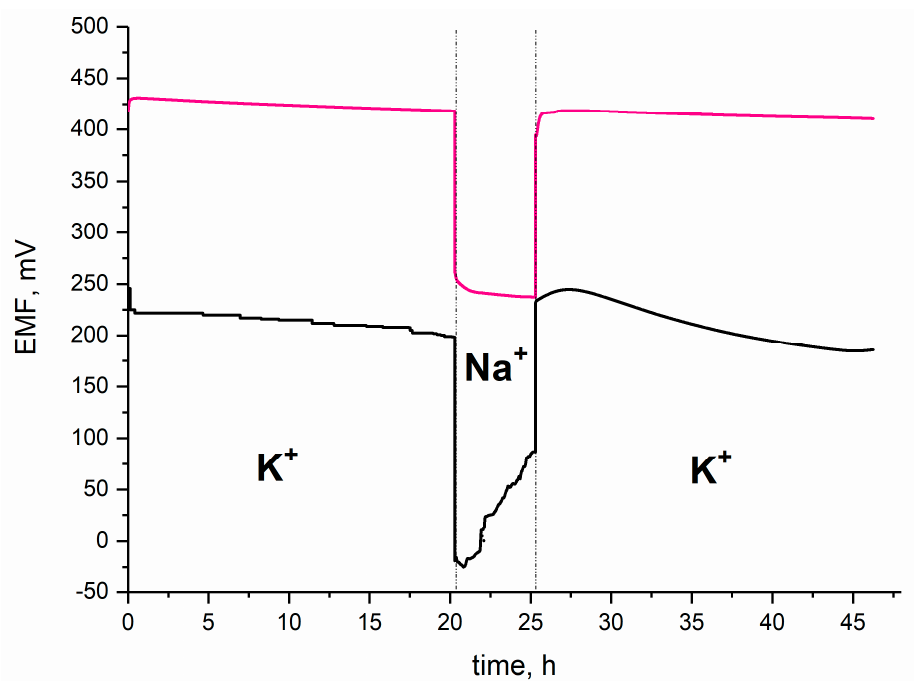
Figure 9. Water layer test conducted for GC/RuO 2 + PEDOT:PSS/K + -ISM and GC/K + -ISM electrode (for one electrode representing each tested group). GC/RuO 2 + PEDOT:PSS(THF)/K + -ISM (pink line), GC/K + -ISM (black line).